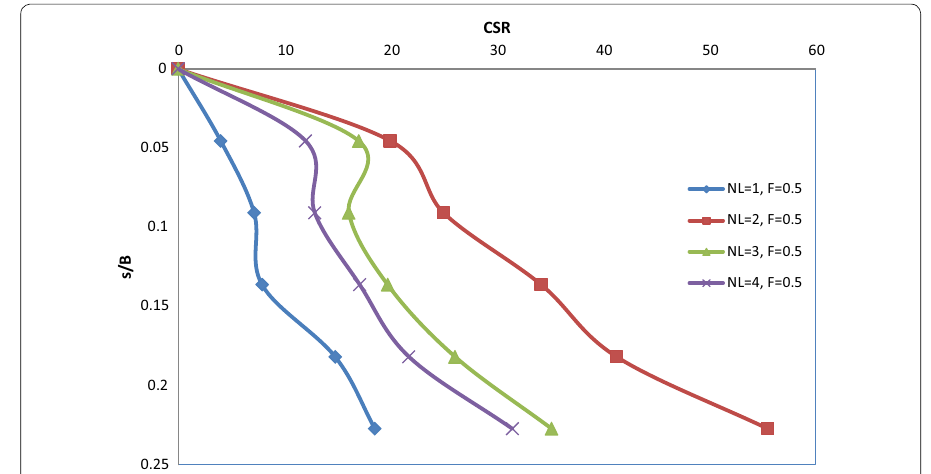
Fig. 8 CSR with s/B for different layer configuration under F